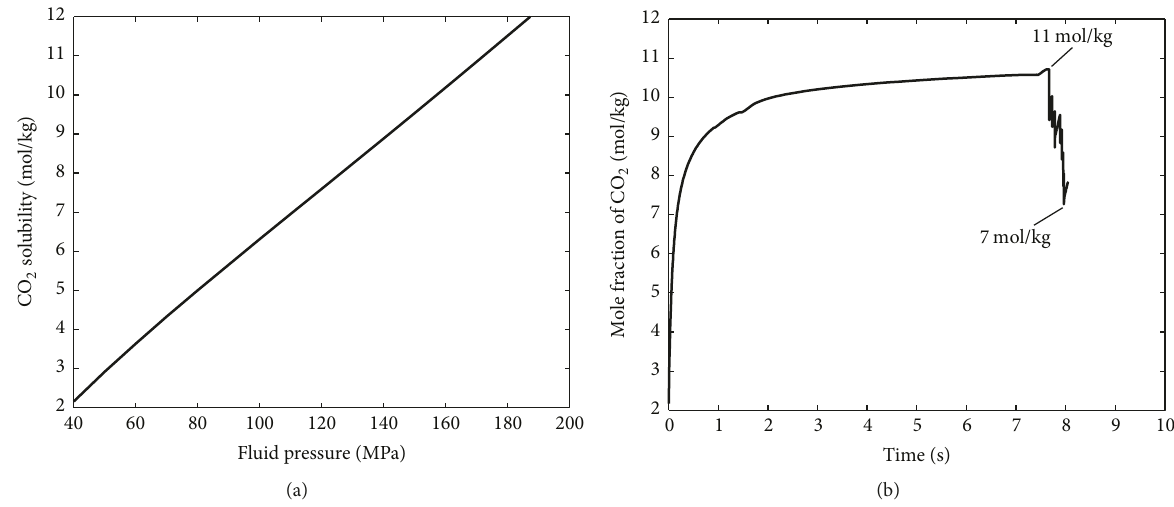
Figure 6: (a) CO 2 solubility in aqueous NaCl solutions against fluid pressure at a temperature of 350 ∘ C, reproduced from the solubility model in [79]; (b) the evolution of CO 2 solubility at the reference point in the numerical